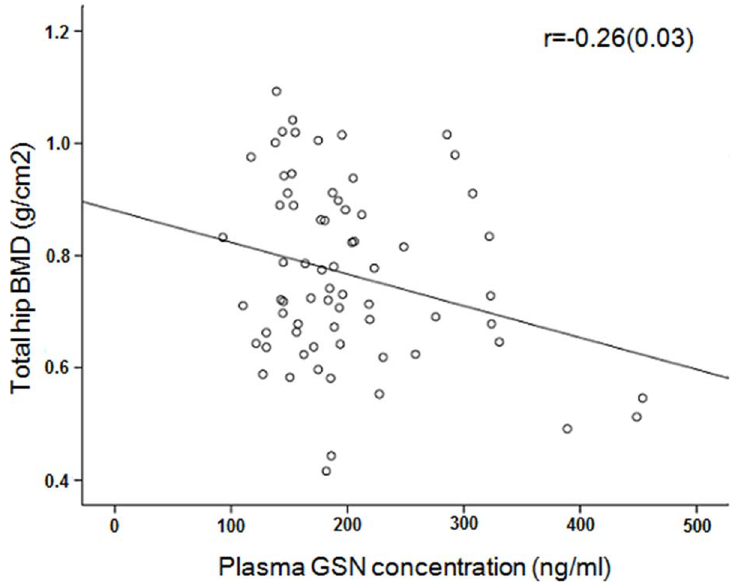
Fig 3. Correlation of plasma GSN concentration with total hip BMD. Partial correlation analysis was conducted to analyze the association of plasma GSN and total hip BMD in the pooled subjects from the Subgroups 2 and 3. We adjusted the effect of covariates BMI, age, P1NP on